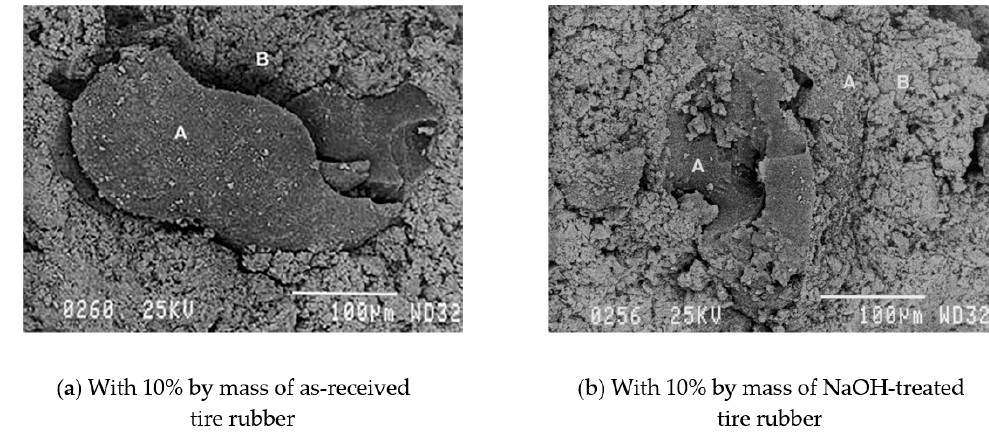
Figure 3. SEM images of fracture surface of cement test specimen. ( a ) Rubber particle; ( b ) Cement paste [27].